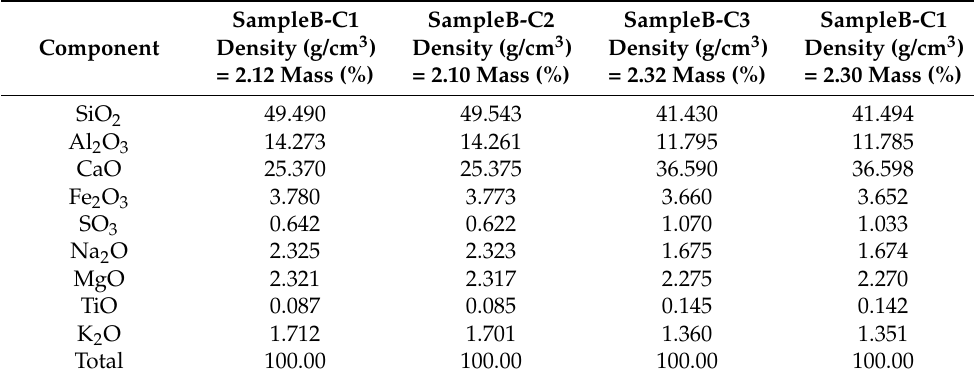
Table 1. The chemical composition of present